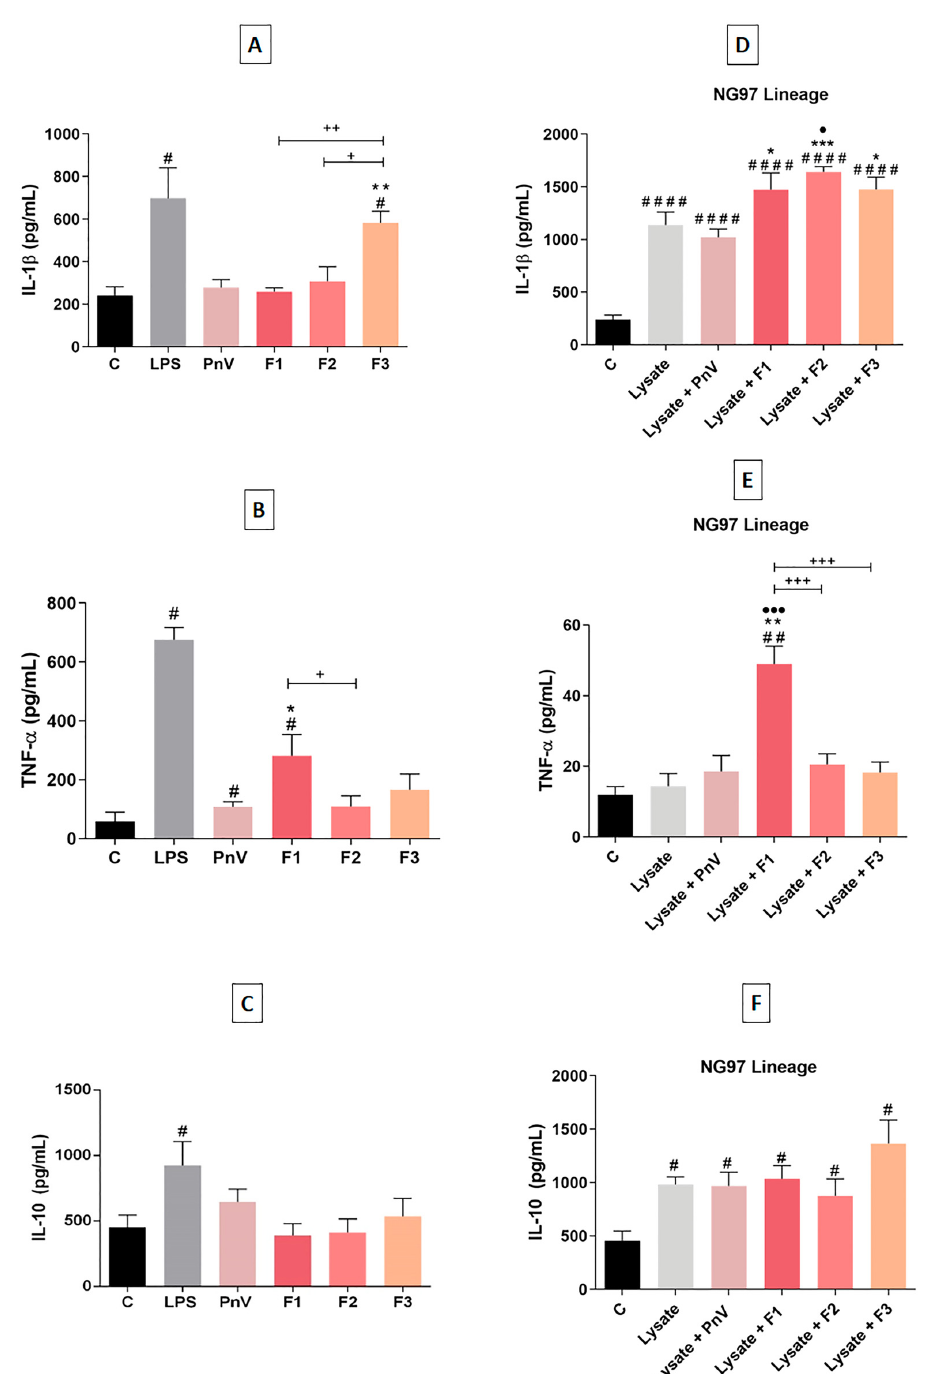
Figure 4. ELISA quantification of cytokines released by DCs in culture. Analysis of pro-inflammatory and anti-inflammatory cytokines (IL-1 β , TNF- α and IL-10) in the supernatant of DCs after stimulation with PnV (14 µ g/mL) and fractions (1.0 µ g/mL), with or without simultaneous glioblastoma cells (NG97) lysate, for 24 h. ( A – C ) Without concomitant lysate stimulation. ( D – F ) With concomitant lysate stimulation. Data were analyzed by one-way ANOVA and Kruskal–Wallis test, presented as mean ± standard error (SEM). Unpaired Student’s t -test was used to compare each treatment with the control. # p < 0.05 compared to the untreated control; # p < 0.05, ## p < 0.01, #### p < 0.0001 compared to the untreated control * p < 0.05, ** p < 0.01, *** p < 0.001 compared to the lysate plus crude PnV group; • p < 0.05, ••• p < 0.001 compared to the lysate group; + p < 0.05, ++ p < 0.01, +++ p < 0.001 compared between fractions. Results of three independent